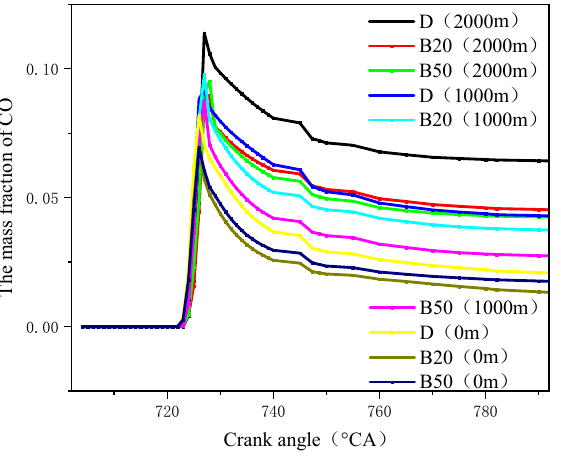
Figure 9. Effect of different plateau environments on the CO emissions of diesel with different blending ratios.